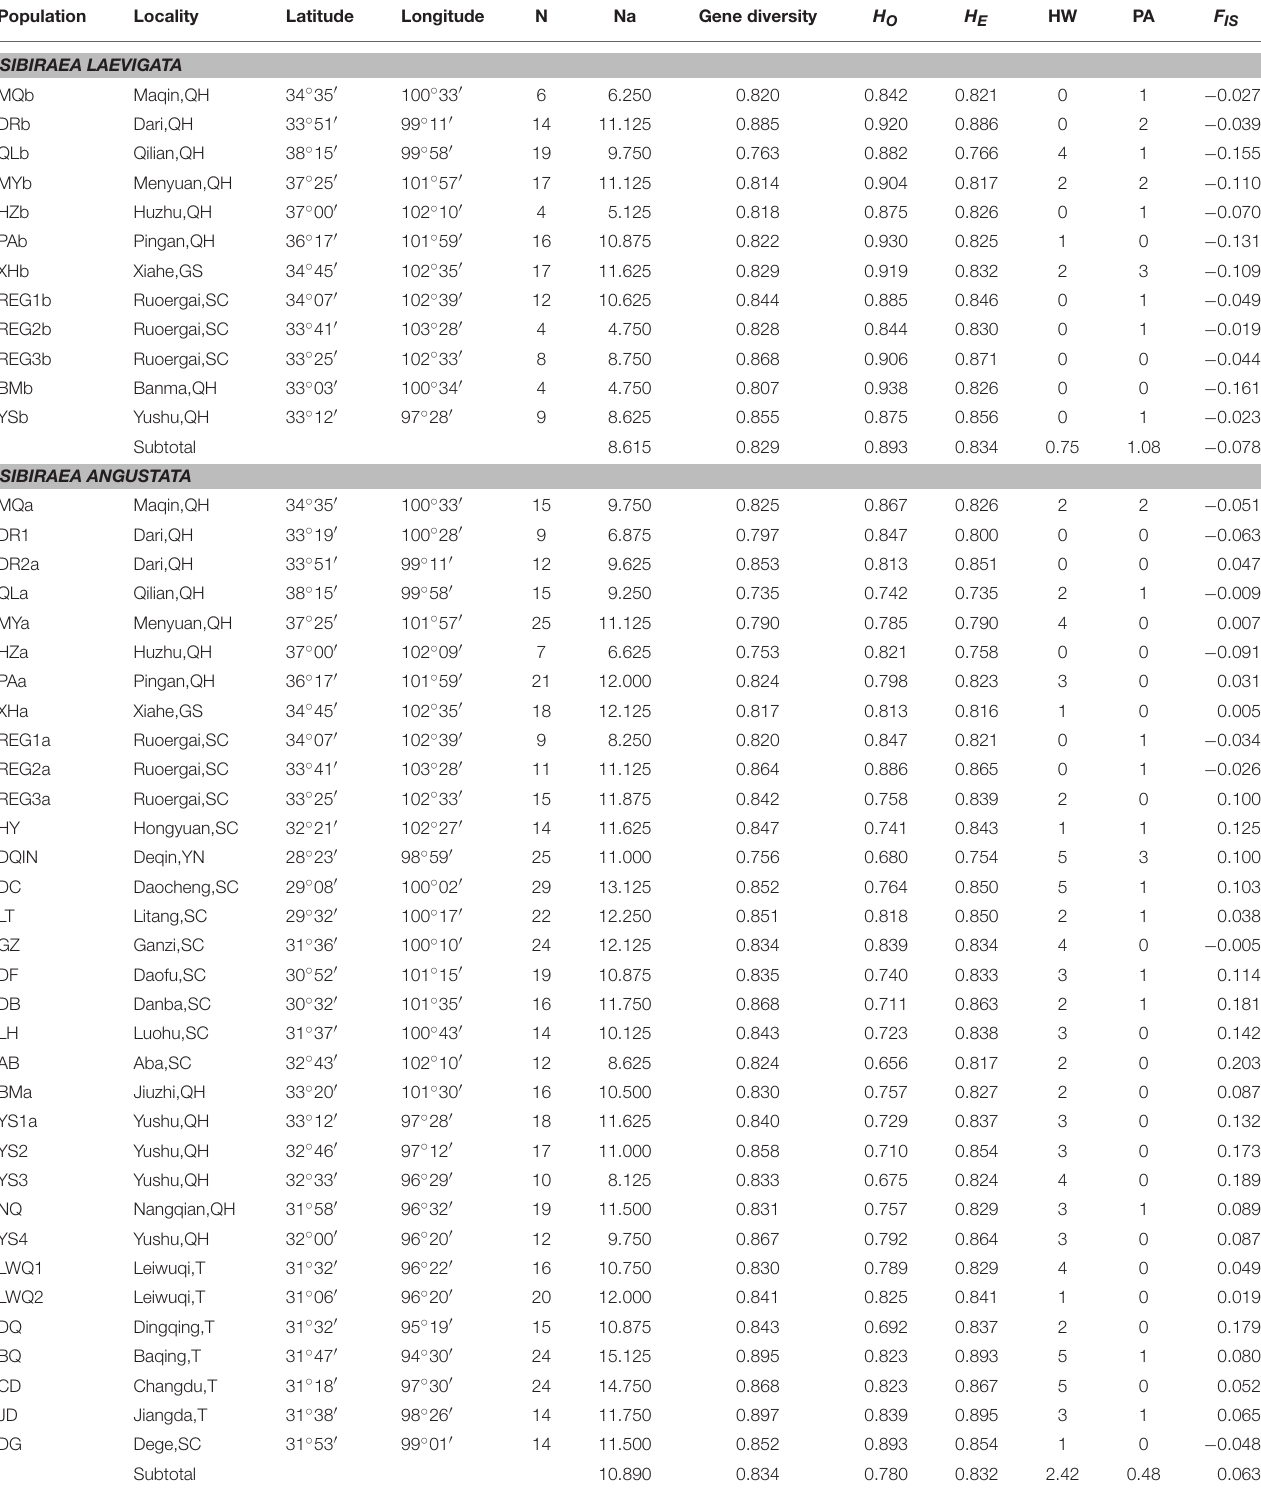
TABLE 1 | Summary statistics for Sibiraea populations in the Qinghai-Tibetan Plateau: sample size (N), average observed heterozygosity over loci ( H O ), average heterozygosity over loci ( H E ), number of loci deviating from Hardy-Weinberg equilibrium (HW), number of private alleles (PA), fixation index ( F IS ). Population